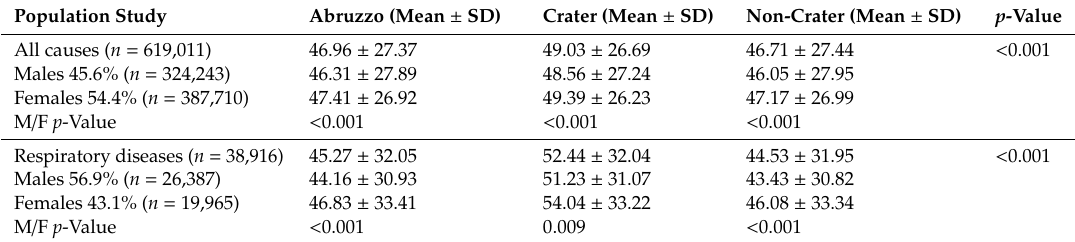
Table 1. Mean age of the population hospitalized by cause of admission. Population